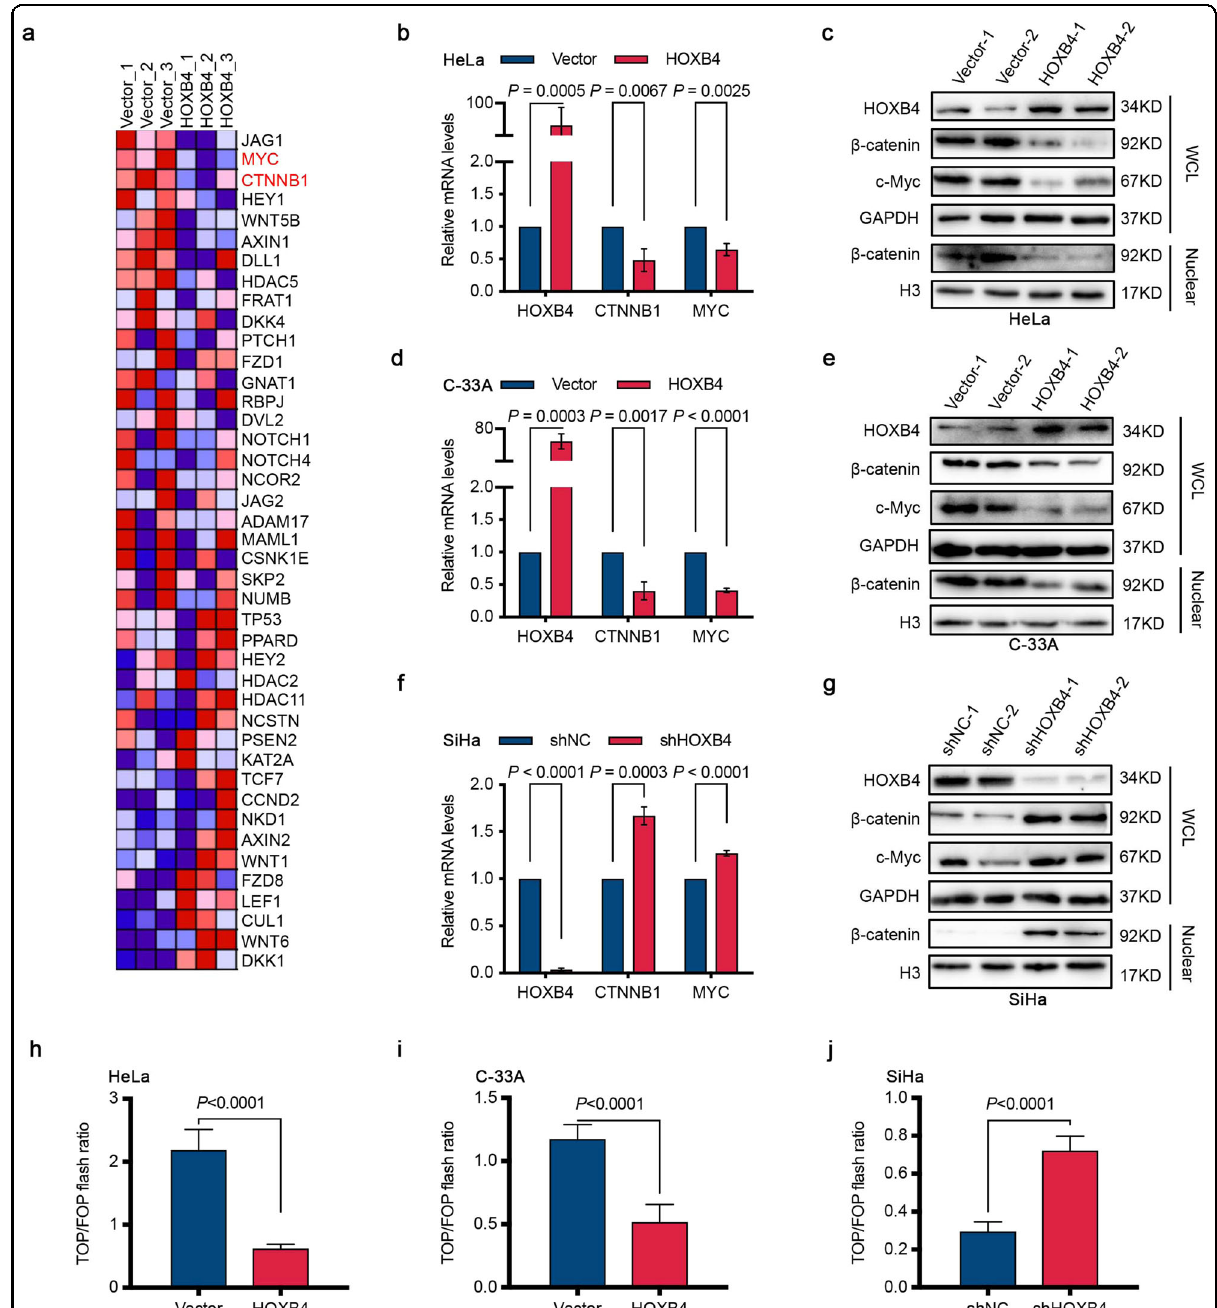
Fig. 4 HOXB4 inactivated the Wnt/ β -catenin signaling pathway. a Heat map of HOXB4 RNA-seq results. All enriched features of the enriched gene sets, which were fi ltered and analyzed by GSEA analysis of HOXB4 RNA-seq data, were shown between the vector control (Vector) and HOXB4- overexpressing (HOXB4) HeLa cells. Gene expression values were represented as colors, where the range of colors (red, pink, light blue, dark blue) showed the range of expression values (high, moderate, low, lowest). n = 3 per group. b – g Expression of β -catenin and c-Myc. The mRNA levels of HOXB4, β -catenin, and c-Myc were detected by qRT-PCR in HOXB4-overexpressing HeLa ( b ) and C-33A ( d ) cells, as well as in HOXB4-depleted SiHa ( f ) cells. Data were normalized to GAPDH. The protein expression of HOXB4, total β -catenin, nuclear β -catenin, and c-Myc was assessed in HOXB4- modi fi ed HeLa ( c ), C-33A ( e ), and SiHa ( g ) cells by western blot and normalized to GAPDH and histone H3 (H3) respectively. h – j Inactivation of the Wnt/ β -catenin reporter luciferase by HOXB4. HeLa ( h ), C-33A ( i ), or SiHa ( j ) cells transfected with the indicated plasmids were analyzed by β -catenin reporter luciferase assays (TOPFlash (TOP) and FOPFlash